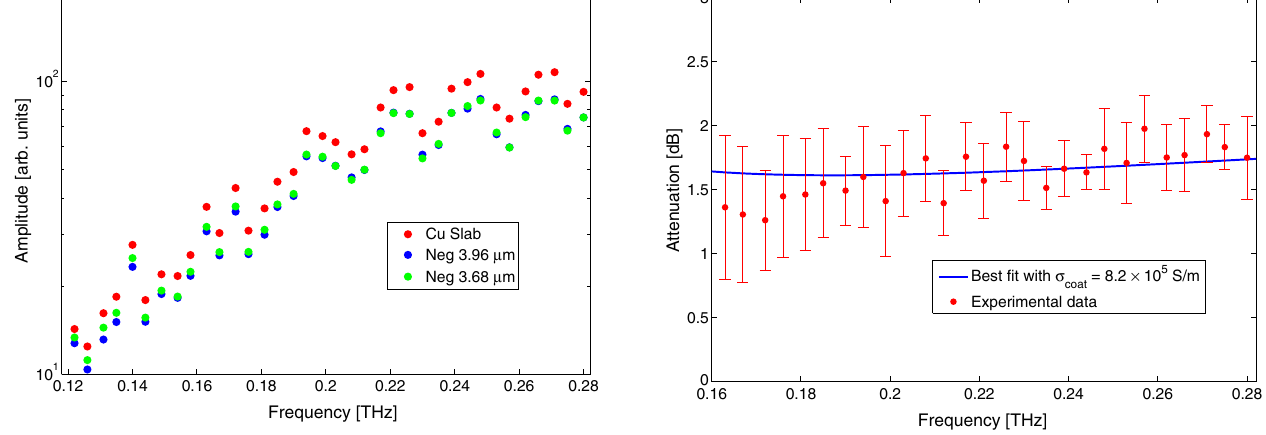
FIG. 15. Attenuation on the NEG coated slab of 3 . 68 μ m: averaged experimental data (red dots) and best fit curve (blue). The value of reduced χ 2 ¼ 0 . 36 .